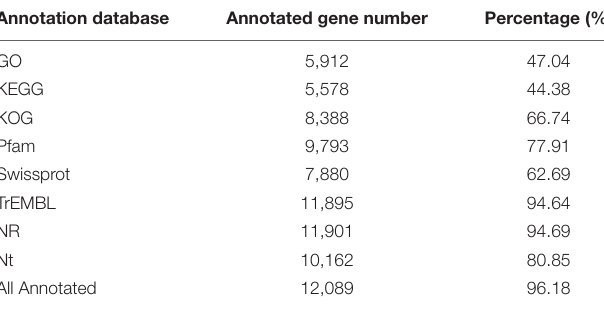
TABLE 2 | Summary of functional annotation for the predicted